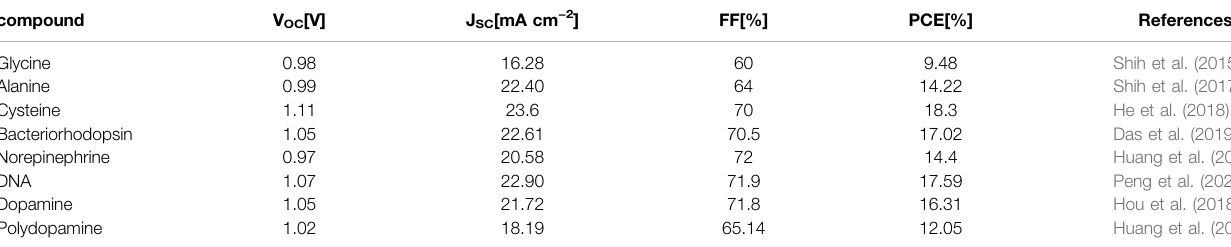
TABLE 4 | Performance of biologically derived